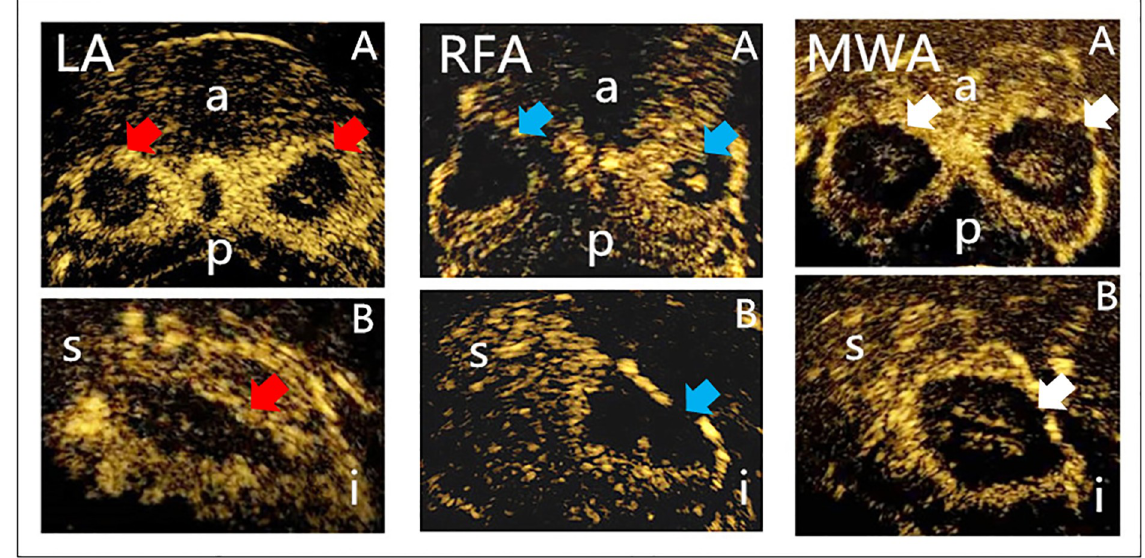
Fig 3. Transverse (A) and longitudinal (B) section images were observed via CEUS after LA, RFA, and MWA (red arrow, LA lesion; blue arrow, RFA lesion; white arrow, MWA lesion; a, anterior; p, posterior; s, superior; i, inferior).